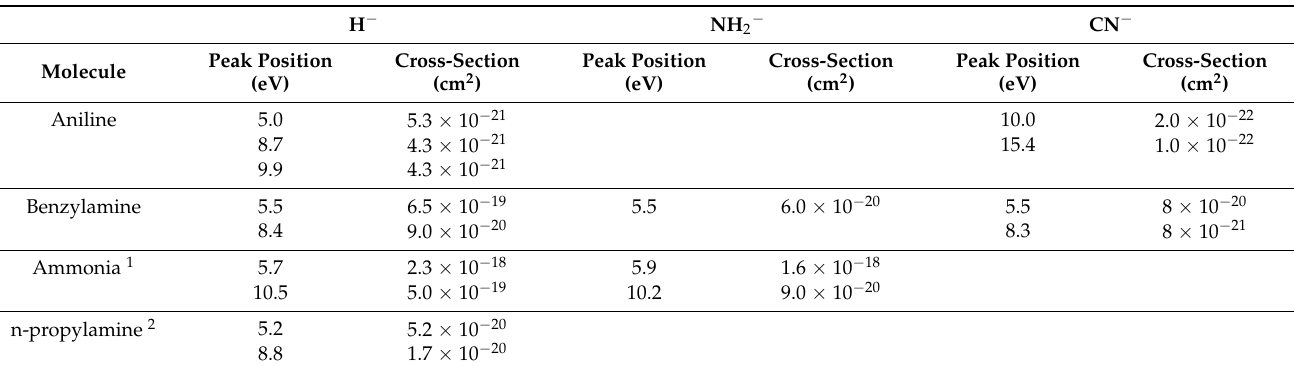
Table 1. Absolute cross-sections for the dominant channels observed in DEA to aniline and ben- zylamine. The absolute cross-sections for ammonia and n-propylamine are also given. In all these values, the typical uncertainty is about 15%.